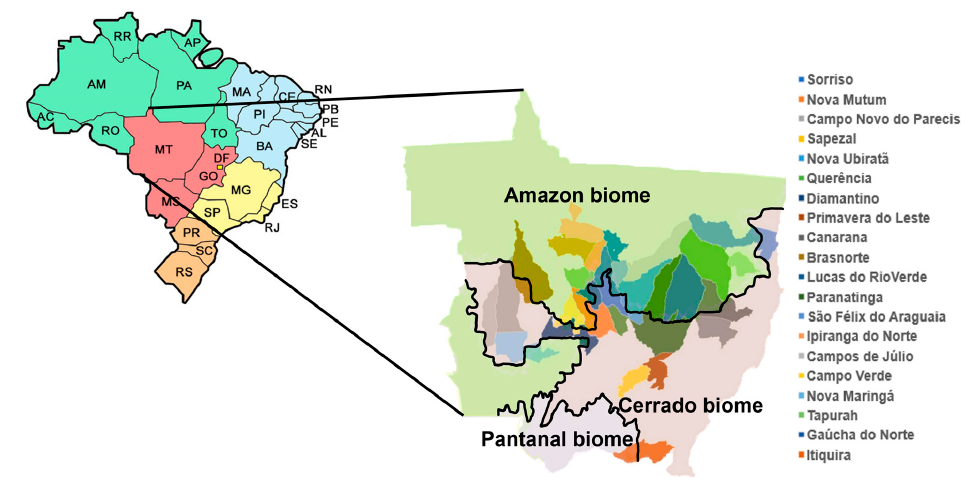
Figure 2. The map of Brazil and the Macro regions, and biome of Mato Grosso State: [37,46]. The Mid-North macro-region is the largest soybean producer in the state. Estimated production for the 2019–2020 harvest according to [17] in 11 million tons, of the 30 munici- palities analyzed, 12 belong to this region, these being Sorriso, Lucas do Rio Verde, Sinop, among others. They represent 34% of the total production in the state. Table 3 highlights the municipality of Sorriso, which alone represents nearly 8% of all state production, followed by Nova Mutum and Campo Novo do Parecis. Table 3. Ranking of Mato Grosso municipalities concerning soybean production. Seq.